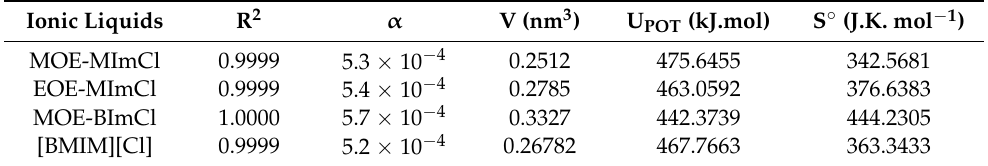
Figure 3. Empirical plot of ILs density. Table 3. The value for linear fitting parameters (R 2 ), thermal expansion coefficient ( α ), molar volume (V), lattice energy (U POT ) and standard molar entropy (S ◦ ) for